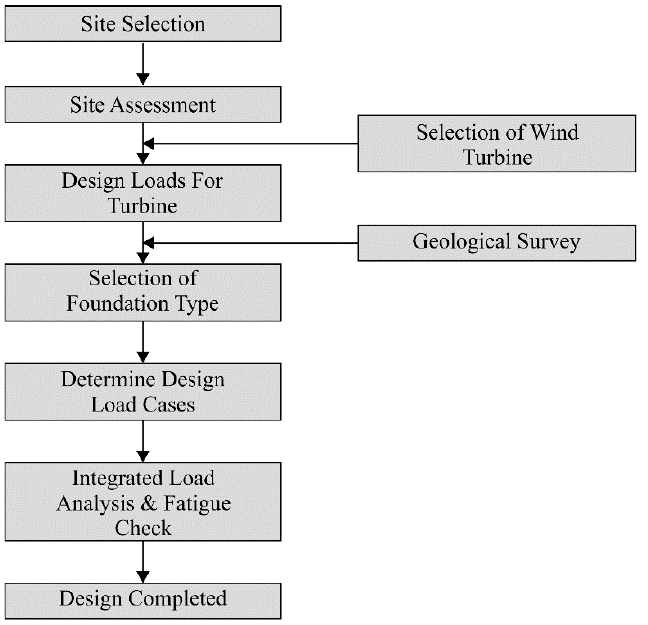
Figure 4. Flowchart of foundation design.